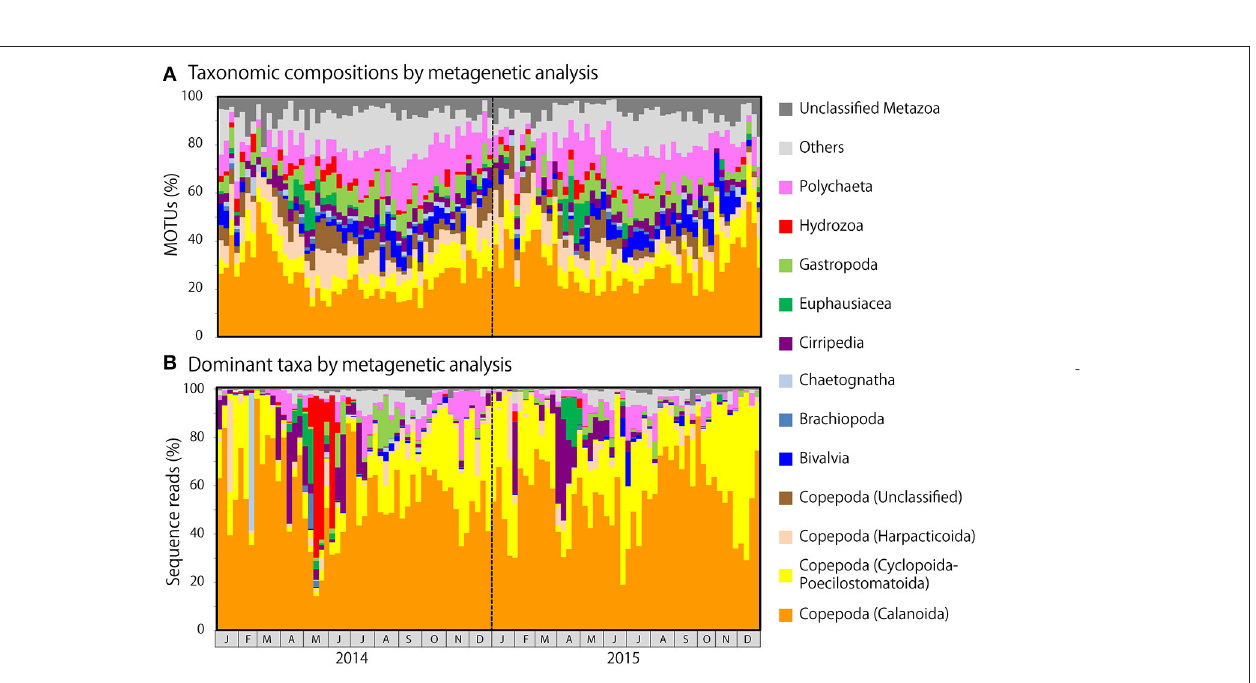
Frontiers in Marine Science | www.frontiersin.org